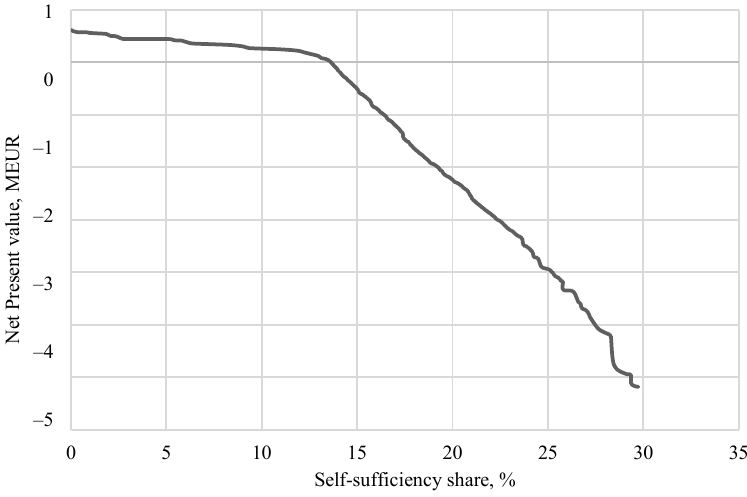
Fig. 2. Pareto optimal solutions in terms of net present value and self-sufficiency